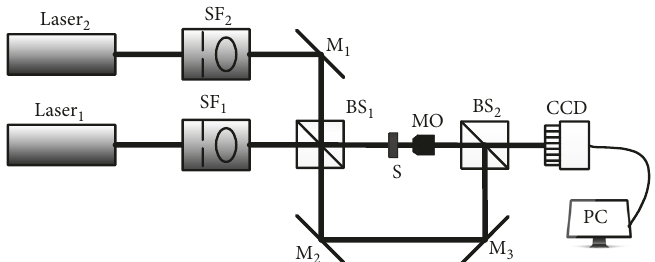
Figure 1: The schematic diagram of dual-wavelength digital holographic microscopy. SF, spatial filter; M, mirrors; BS, beam splitters; S, sample; MO, microscope objective; CCD, charge-coupled devices; PC, personal computer.